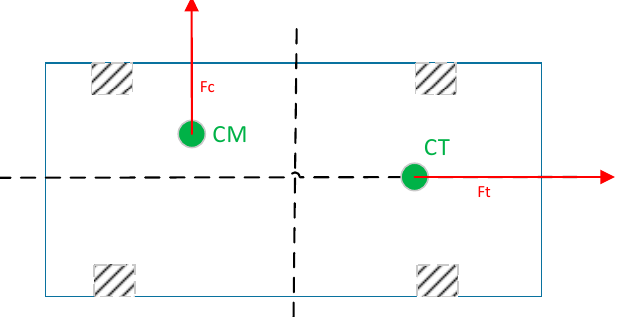
Figure 13. Center of mass and center of traction. Straight movement.